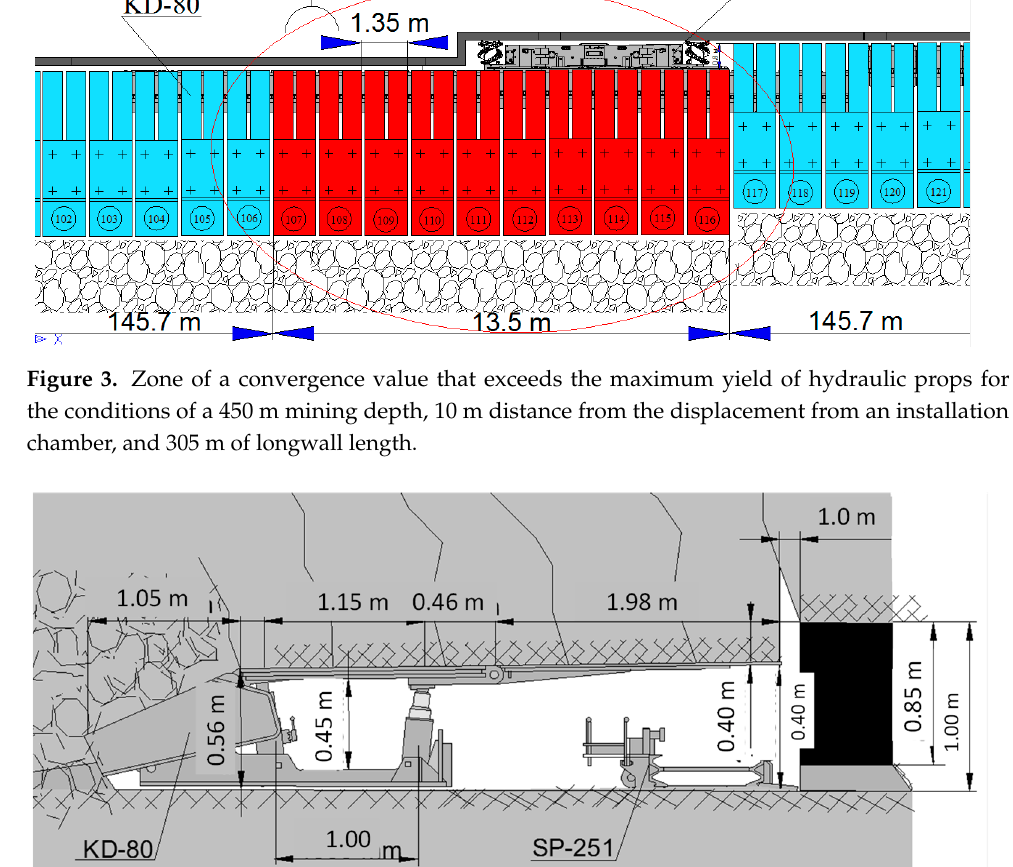
Figure 4. Cutting of the roof rock along the stope line, resulting in rigid settlement of the support units.